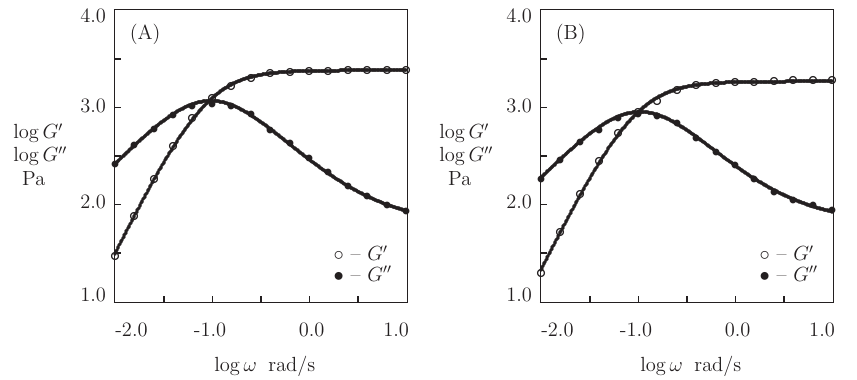
Figure 3. Storage modulus G (cid:48) and loss modulus G (cid:48)(cid:48) versus frequency ω . Symbols: experimental data [68] on four-arm PEG gel cross-linked by benzaldehyde-thiol complexation of PEG-BCA and PEG–thiol chains. ( A )–virgin sample, ( B )–cut and healed sample. Solid lines: the results of